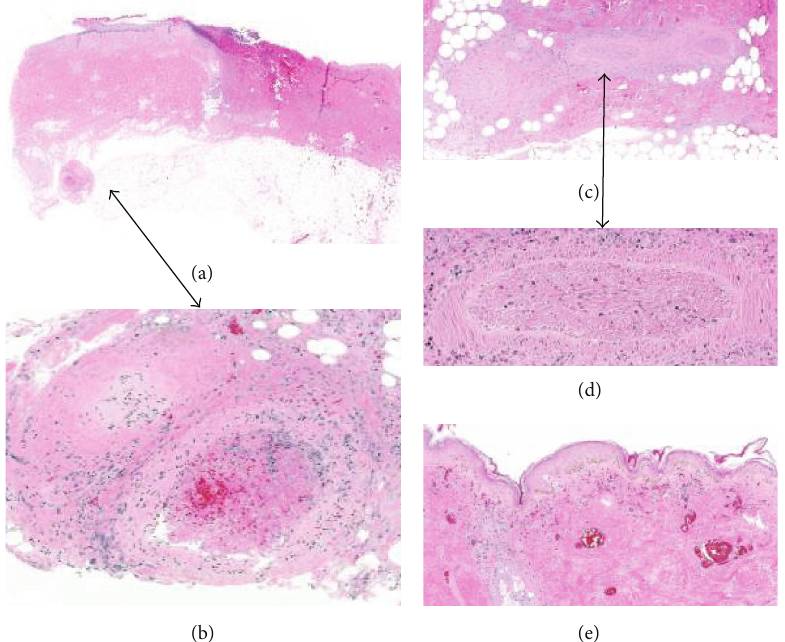
Figure 2: Necrotizing cutaneous polyarteritis nodosa. (a) and (b) exhibit a nodule of arteritis in the subcutis (arrows). (c) and (d) show extensive arterial damage seen as both angiodestructive inflammation and thrombotic occlusion. (e) highlights vascular congestion and extensive coagulative necrosis of epidermis and dermal adnexae. Extensive necrosis of adipocytes (see (c)) was also found indicating that arteritis caused significant ischemic damage to the surrounding